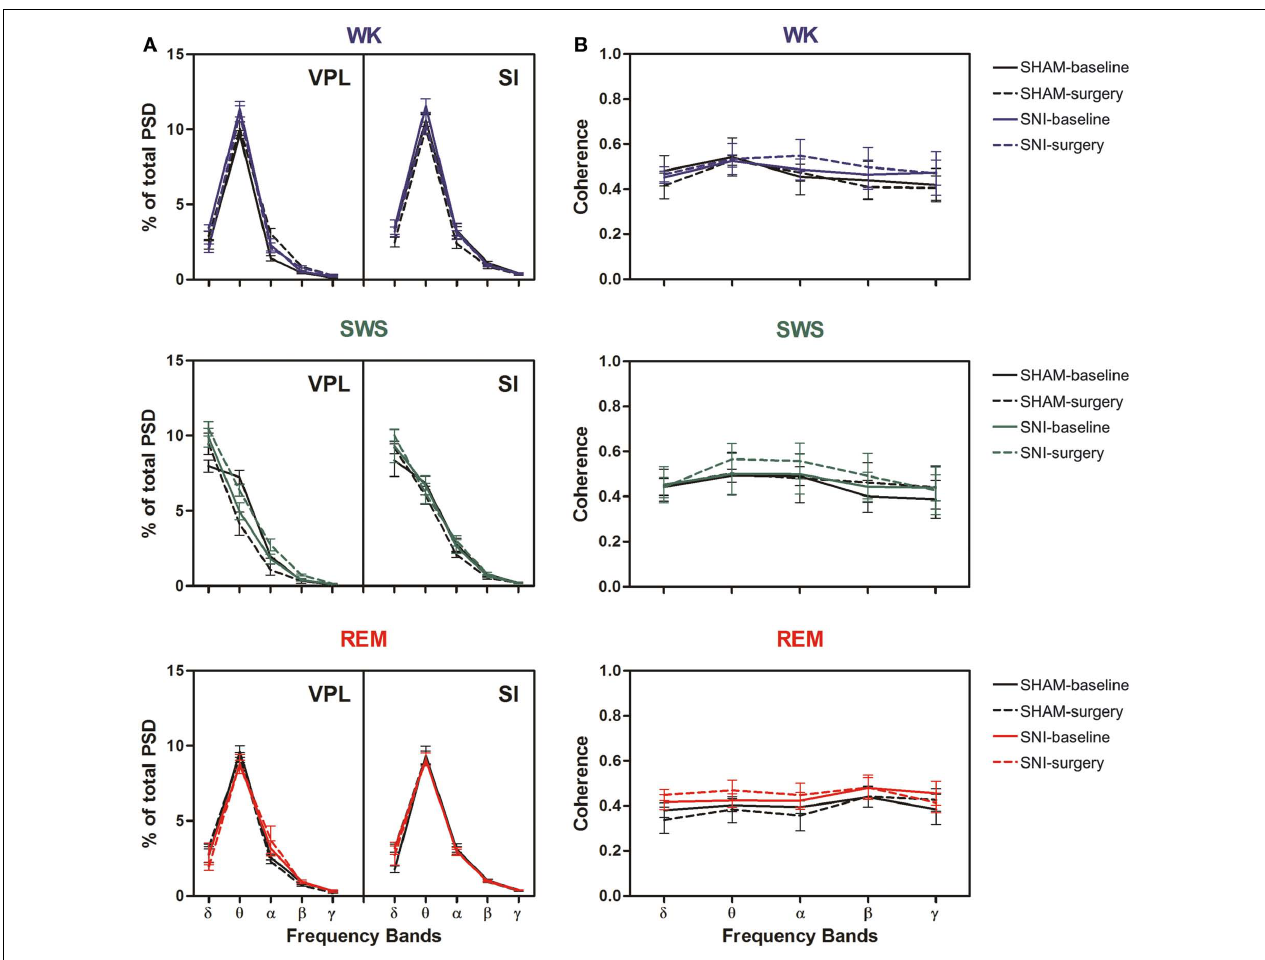
FIGUREA3 | Spectral analysis of SI–VPL LFPs channels duringWK (blue), SWS (green), and REM (red) state episodes across frequency bands. Frequency bands: delta ( δ , 1–4Hz), theta ( θ , 4–9Hz), alpha ( α , 9–15Hz), beta ( β , 15–30Hz), and slow-gamma ( γ , 30–50Hz). Each point represents the mean value within the frequency band. Experimental groups were represented: SHAM-baseline (continuous black line), SHAM-surgery (black line-dotted), SNI-baseline (continuous color line:WK (blue), SWS (green), and REM (red), and SNI-surgery (color line-dotted). (A) Left column represents the power spectra density (PSD) measurements across frequency bands for the two recorded areas (ventro-posterior-lateral thalamic nuclei,VPL and primary somatosensory cortex – SI). Analysis of variance revealed no differences across experimental groups [(SHAM-baseline/SHAM-surgery) –VPL:WK F (1,25) = 1.61, P = 0.1874, SWS